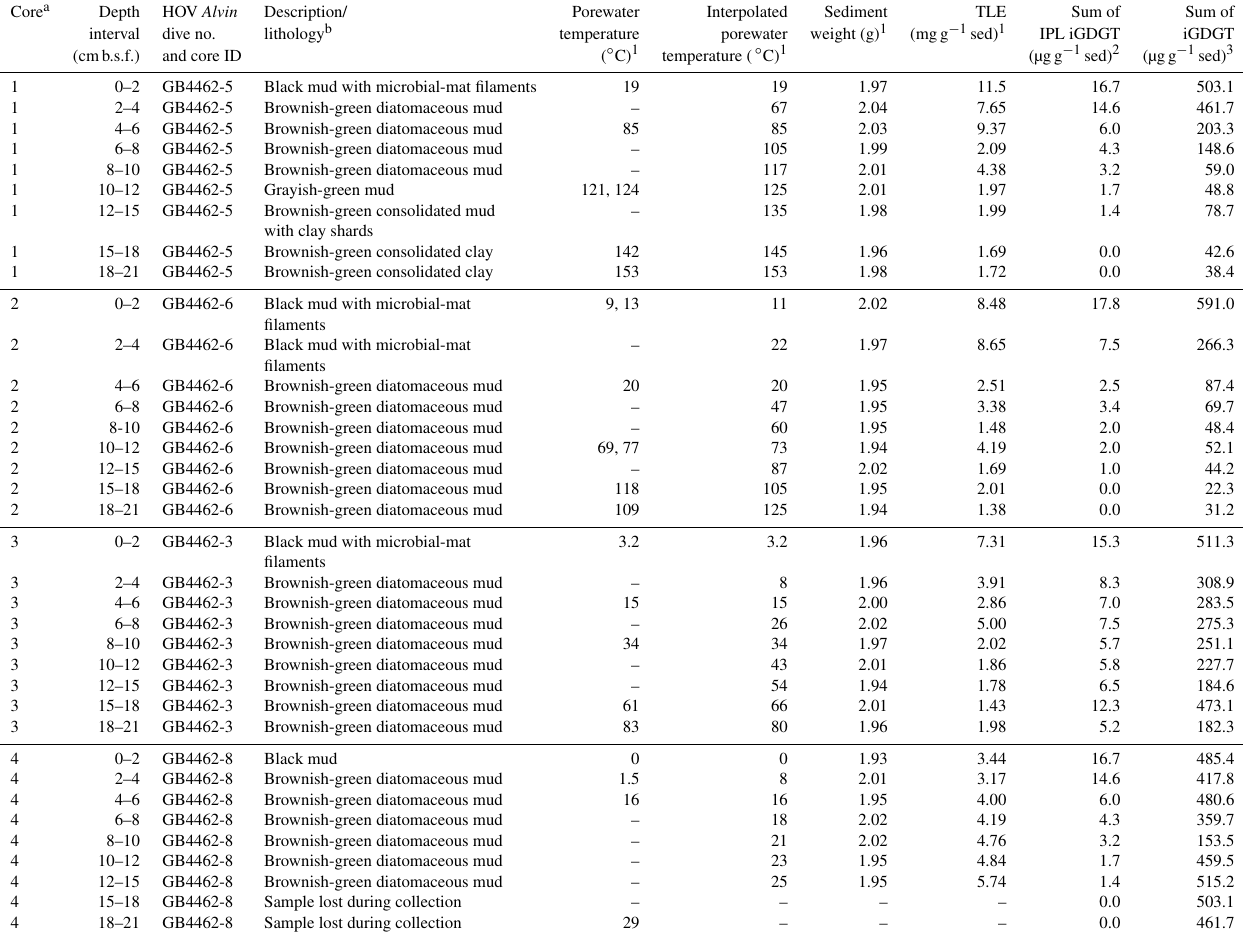
Table 1. Cathedral Hill sample push core, sediment (sed), geochemical, and lipid proxy data. Core